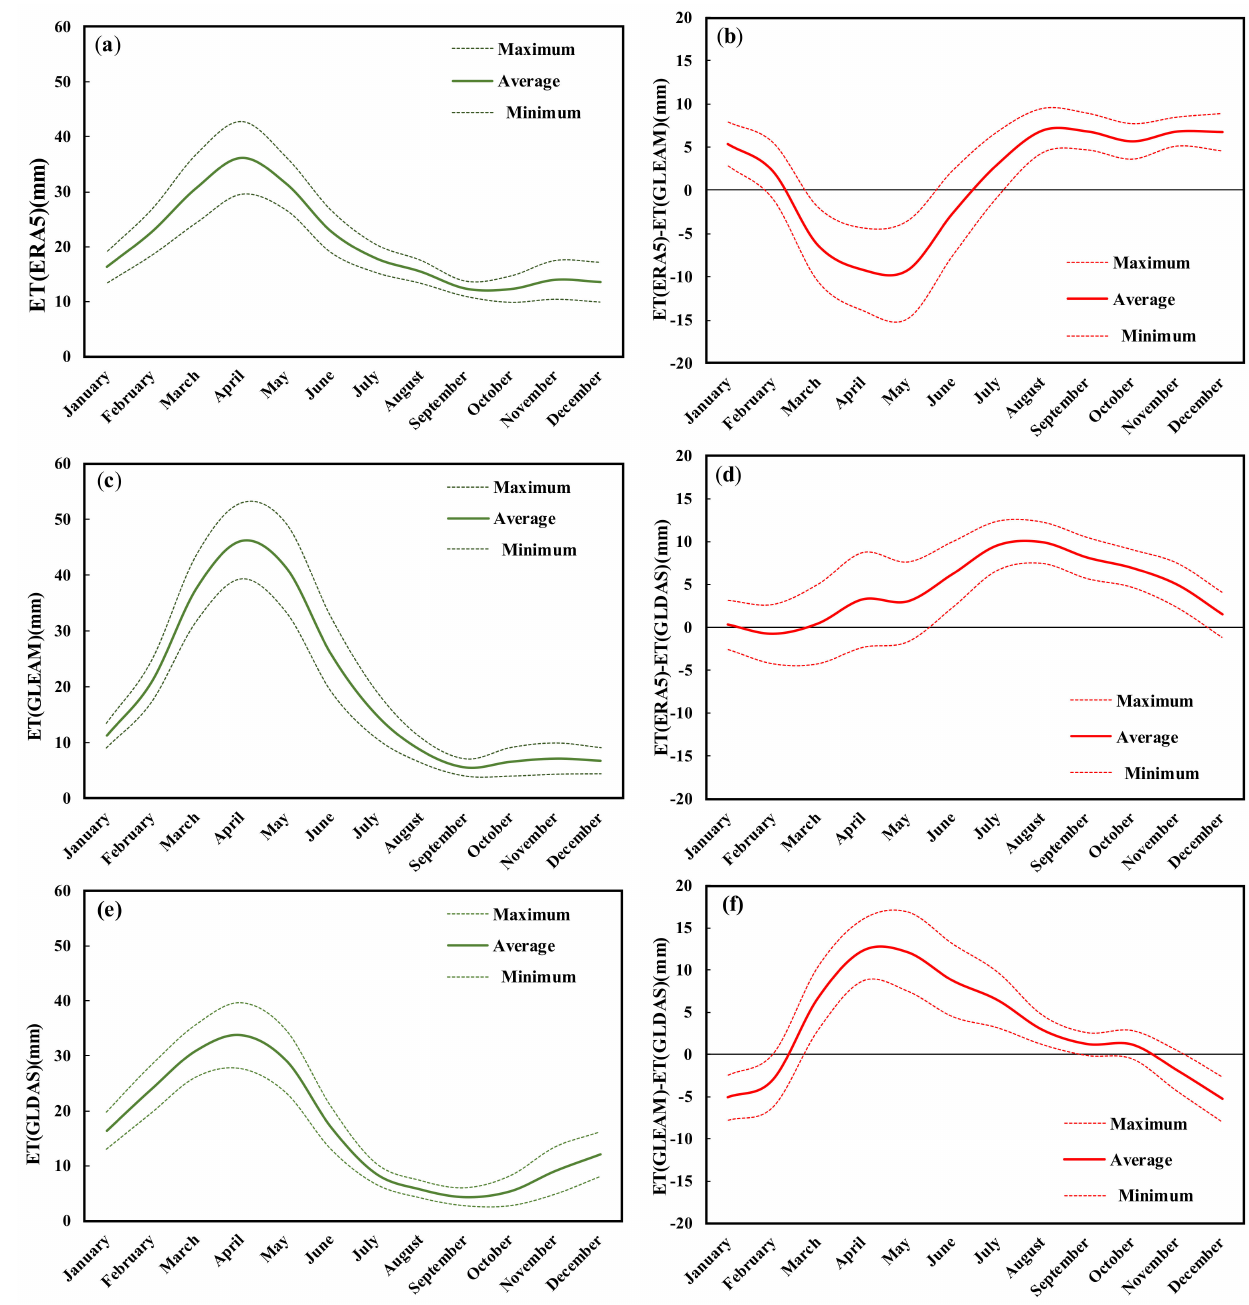
Figure 3. Long term (1980–2018) monthly average, maximum and minimum values of evapotranspiration (ET, mm) and monthly average, maximum and minimum difference between datasets over Iran according to ( a ) the ET ERA5 dataset, ( b ) ET ERA5 –ET GLEAM , ( c ) the ET GLEAM dataset, ( d ) ET ERA5 –ET GLDAS , ( e ) the ET GLDAS dataset, and ( f ) ET GLEAM –ET GLDAS